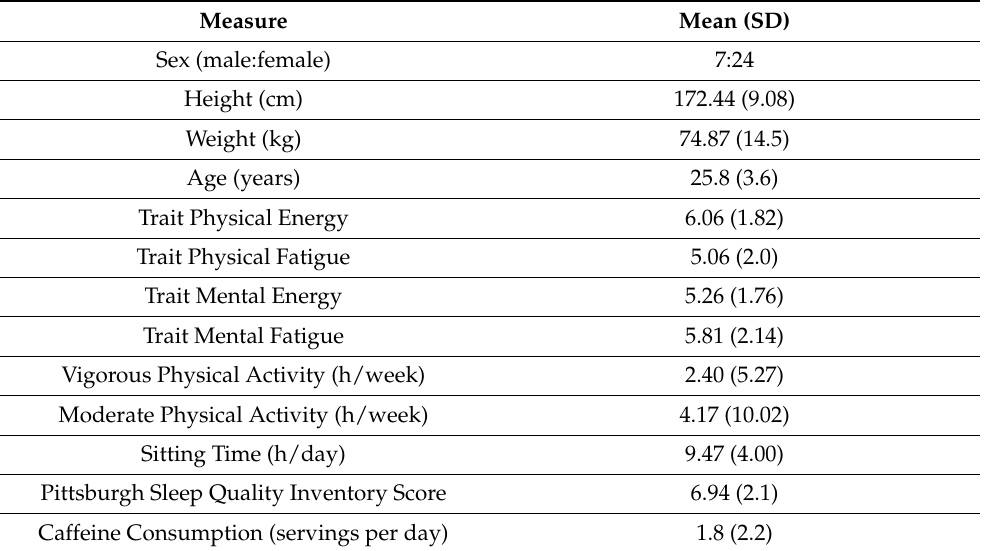
Table 1. Participant characteristics (n =